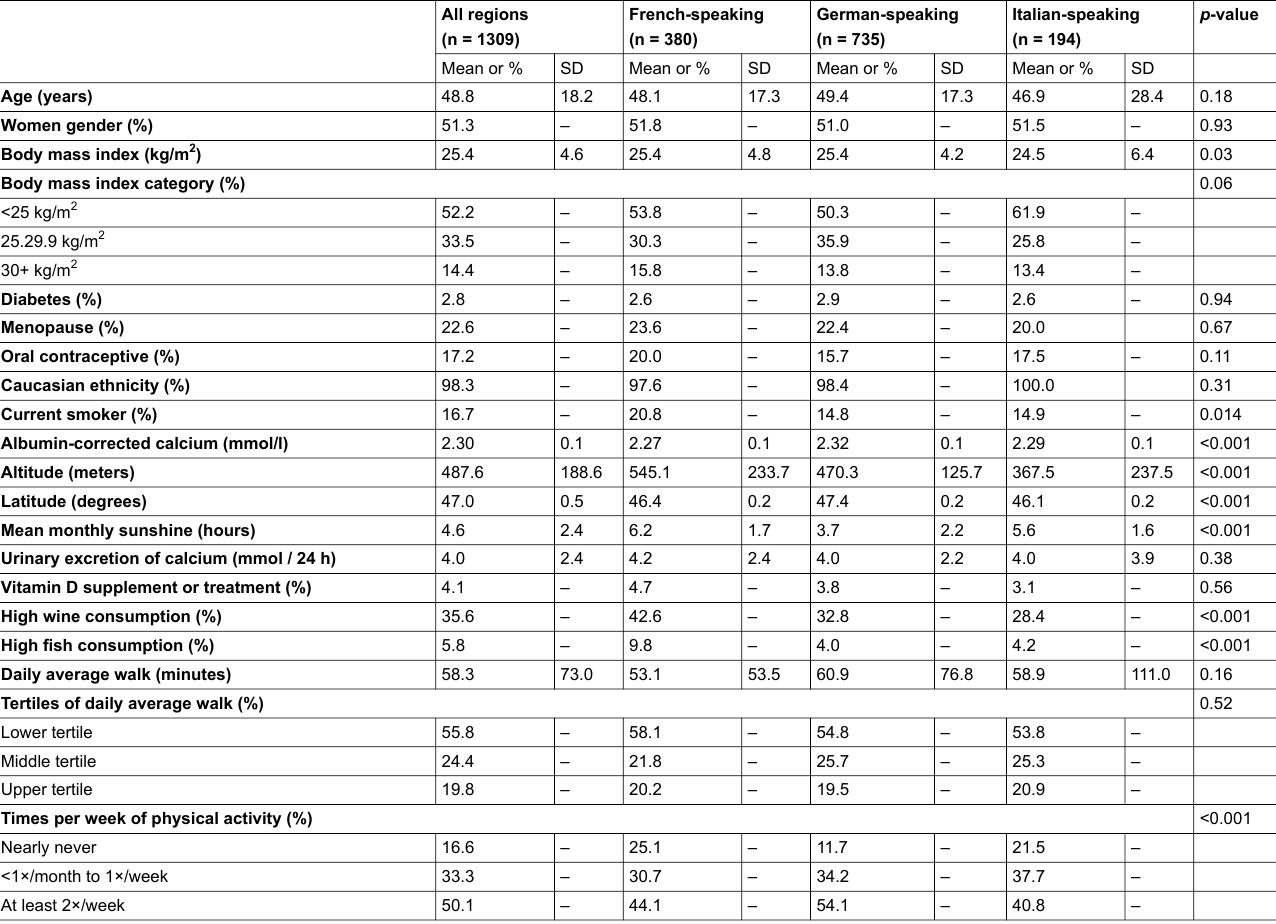
Table 1: Characteristics of the 1,309 individuals from the Swiss Study on Salt Intake included in the analyses, by region.